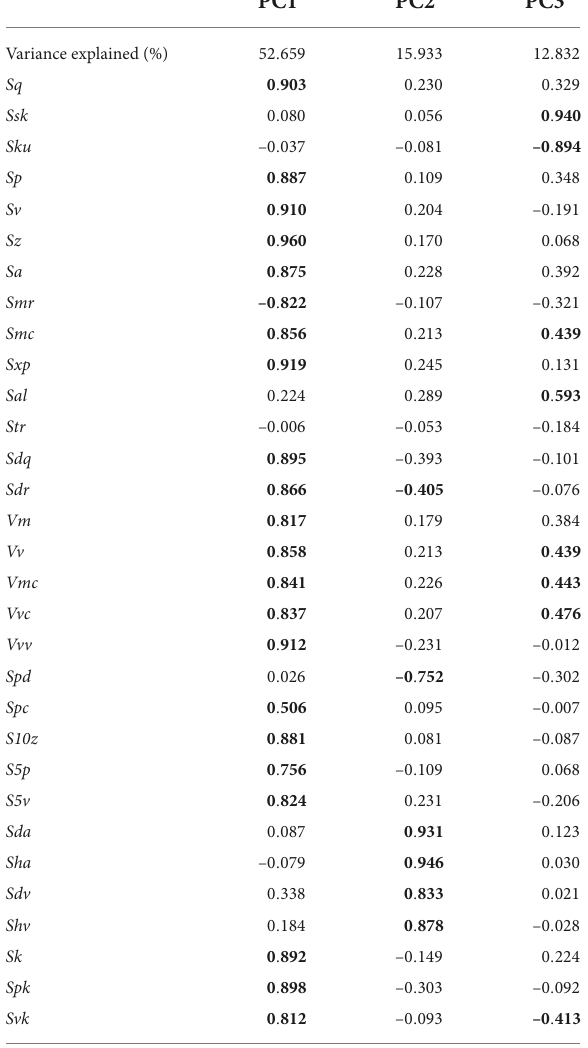
TABLE 3 Factor loadings obtained from PCA conducted using 31DMT